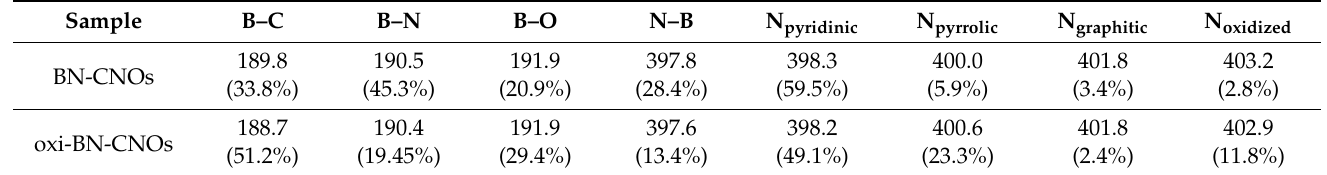
Table 2. Chemical state, positions (eV), and relative area percentages of the deconvoluted C 1s peaks obtained from XPS analyses of BN- and oxi-BN-CNOs.